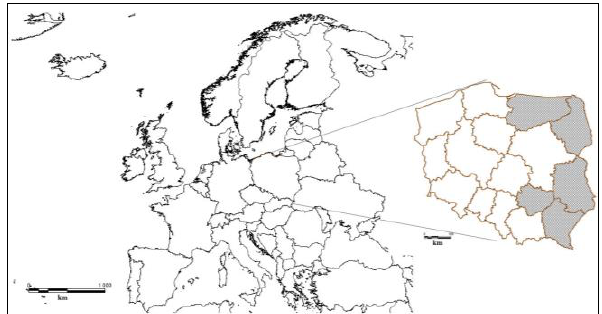
Fig. 3. Study area: Eastern Poland macroregion (Source: Own